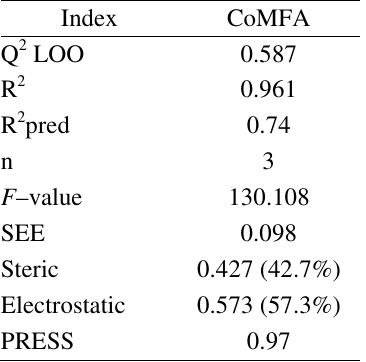
experimental versus p IC 50 Table 3. CoMFA PLS results